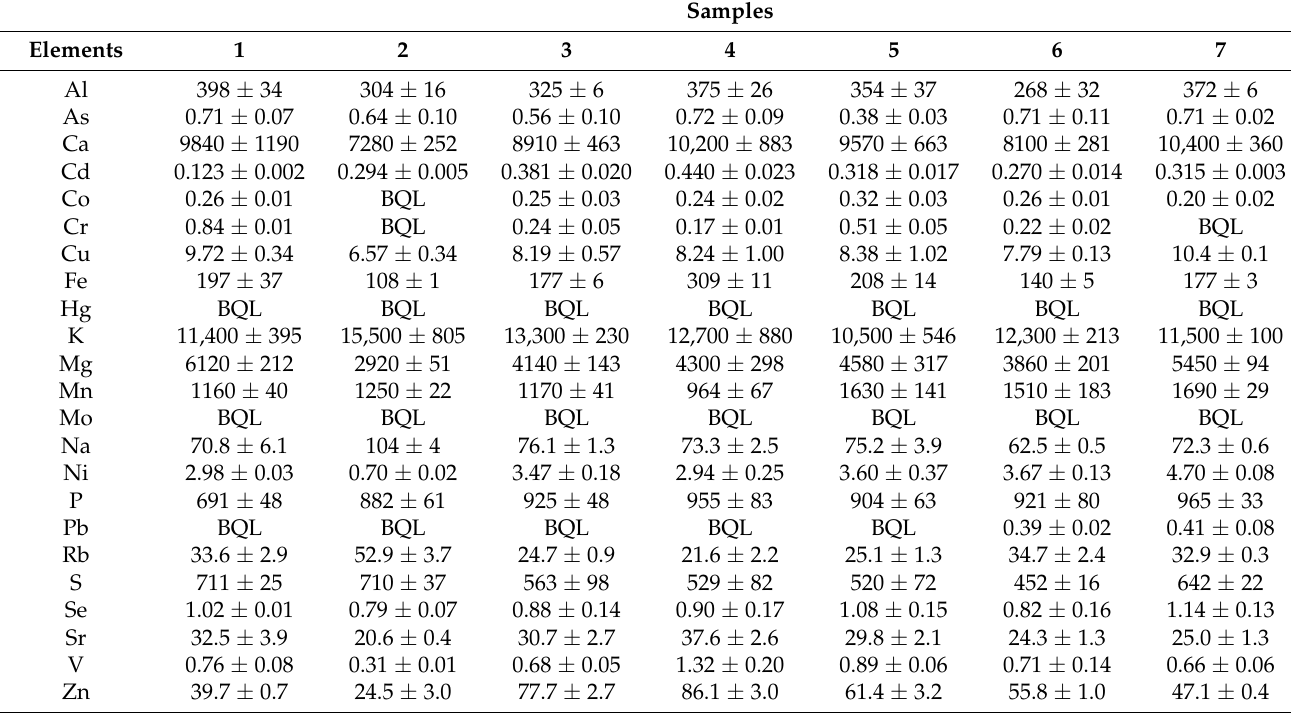
Table 2. Total content (mean ± SD, mg kg − 1 ) of 23 elements in yerba mate (Ilex paraguariensis) .